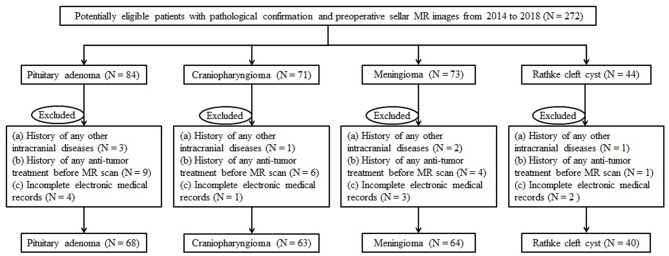
Workflow chart of the patient enrollment process.